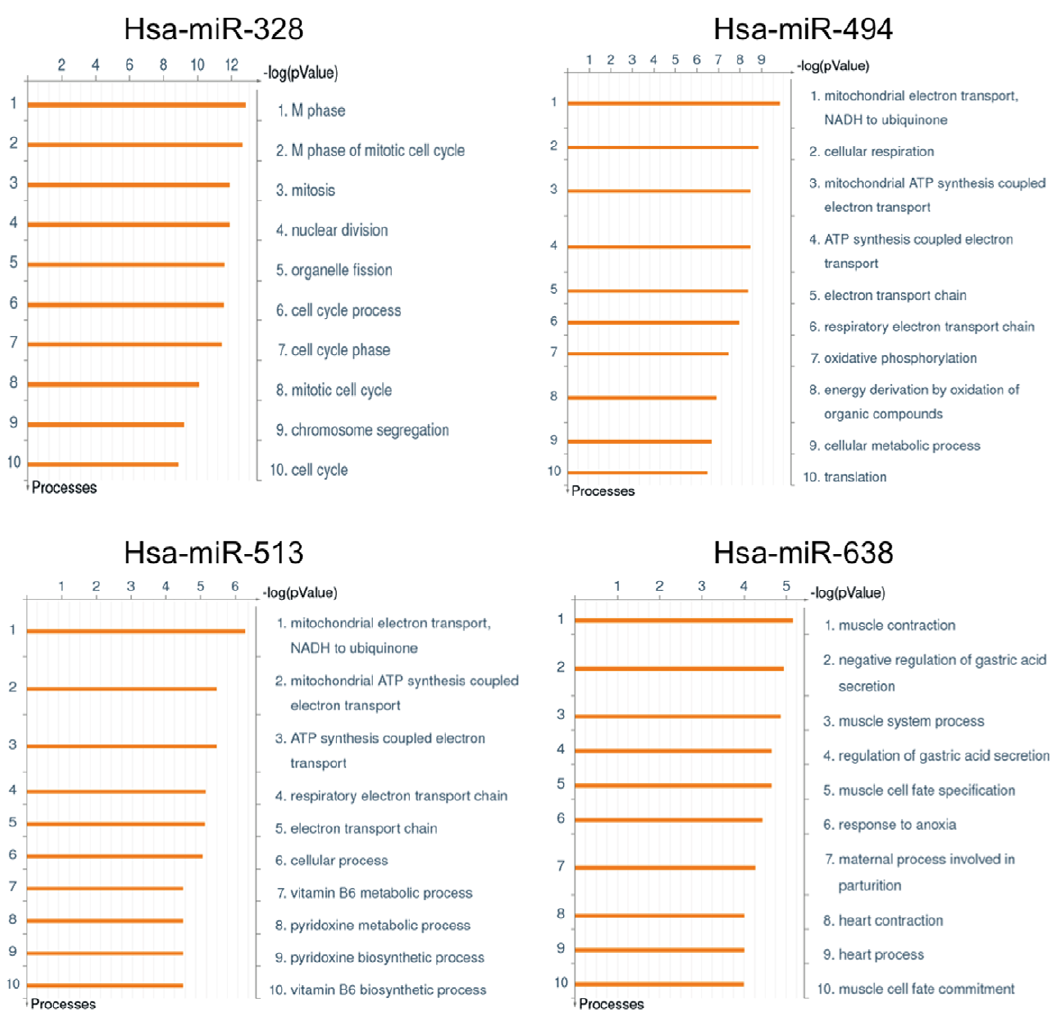
Figure 6. Ontology enrichment analysis for target genes of hsa-miR-328, hsa-miR-494, hsa-miR-513 and hsa-miR-638. The ExParser algorithm was used to compile datasets of genes whose expression patterns were comparable and statistically correlated to the expression patterns of the four mitomiRs. The datasets were uploaded into MetaCore TM and analyzed in respect to the Gene Ontology Process. Ten most significantly enriched processes for the genes targeted by hsa-miR-328, hsa-miR-494, hsa-miR-513 and hsa-miR-638 were scored and ranked in respect to the obtained p-values. Bars represent significance as 2 log(p-value) for hypergeometric distribution. Ontology enrichments were all filtered to allow no more than 5% false discovery